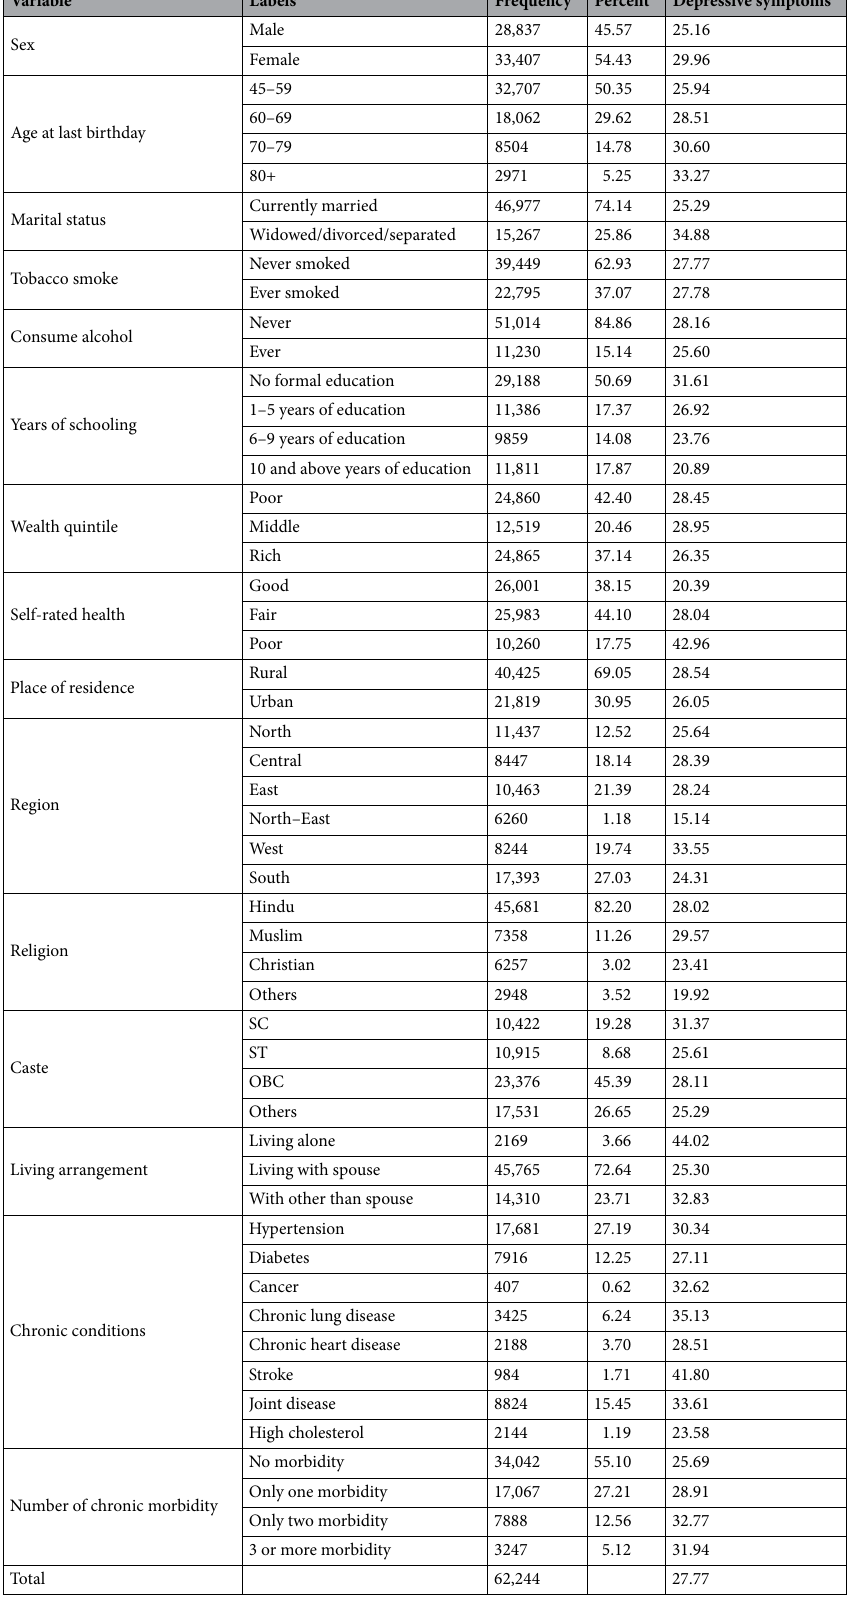
Table 1. Background characteristics of study population, LASI Wave 1 (2017–2018). Total, N = 62,244, percentage distribution are